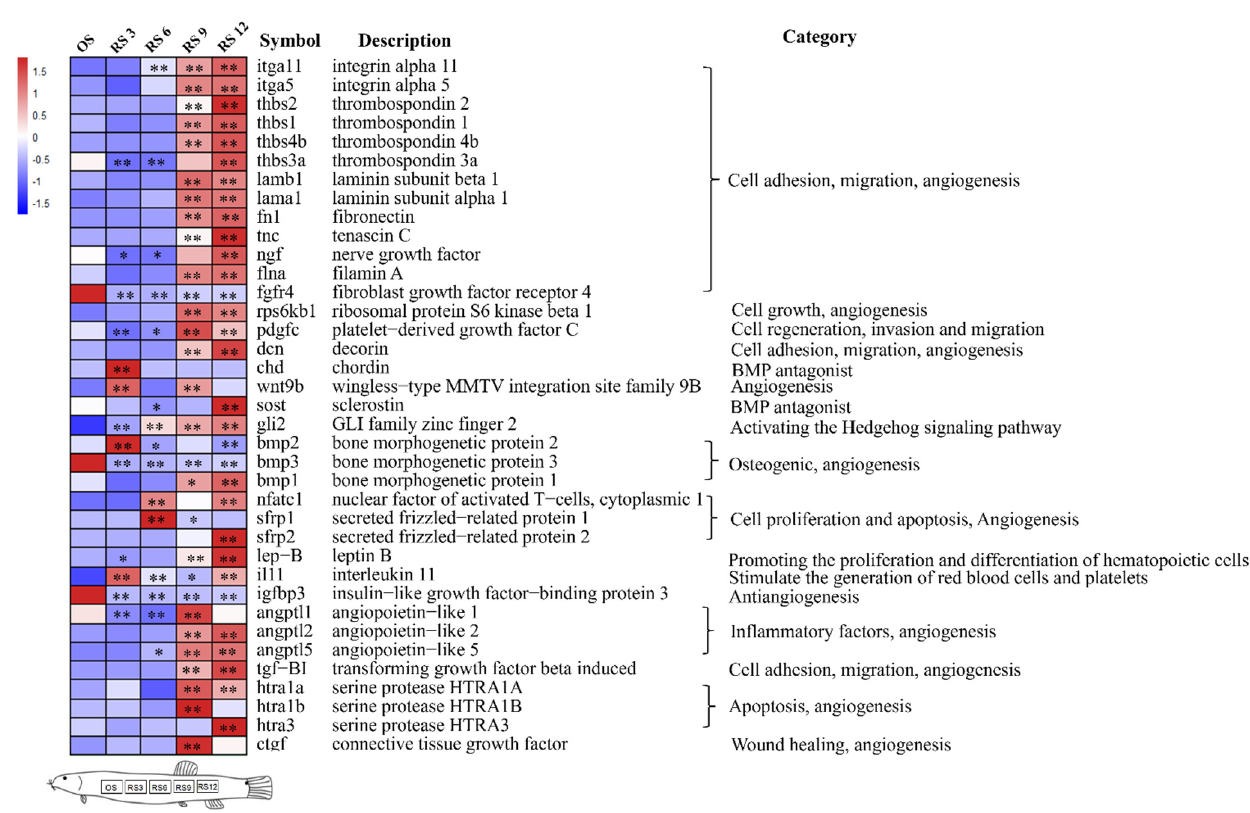
Figure 5. Expression profiles of cutaneous air-breathing formation related genes in regenerated skin of loach. OS: original skin; RS3: regenerated skin of the 3rd day after cutaneous incision (daci). RS6: regenerated skin of the 6th daci. RS9: regenerated skin of the 9th daci. RS12: regenerated skin of the 12th daci. * indicates significant difference of gene express level between regenerated skin and original skin (* p < 0.05, ** p < 0.01).